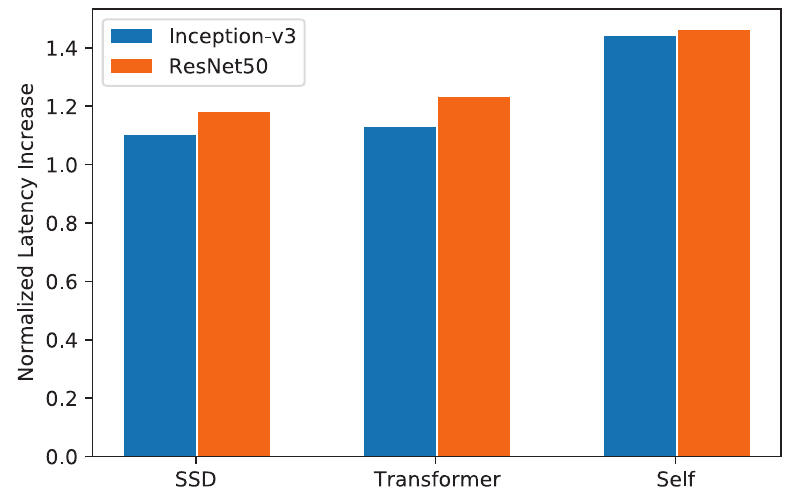
Figure 3. Latency increase compared to solo-running latency when bi-instance inference executes on a single GPU. Inception-v3 and ResNet50 instances experience the largest latency increase when co-located with